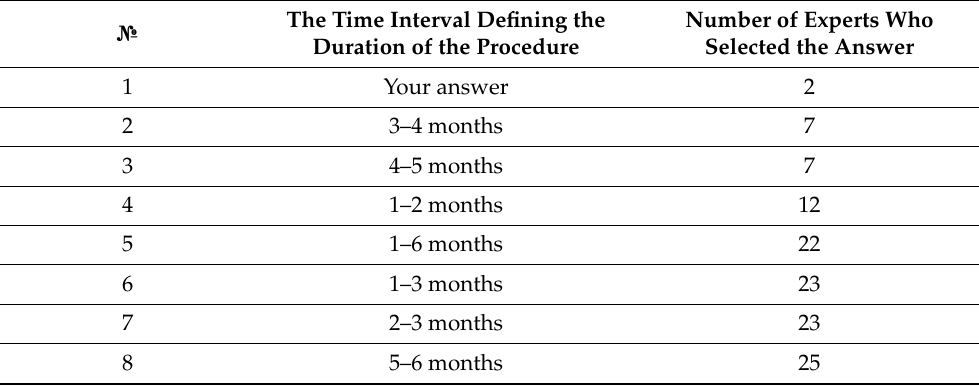
Table A2. Calculated ranked data of the survey results.